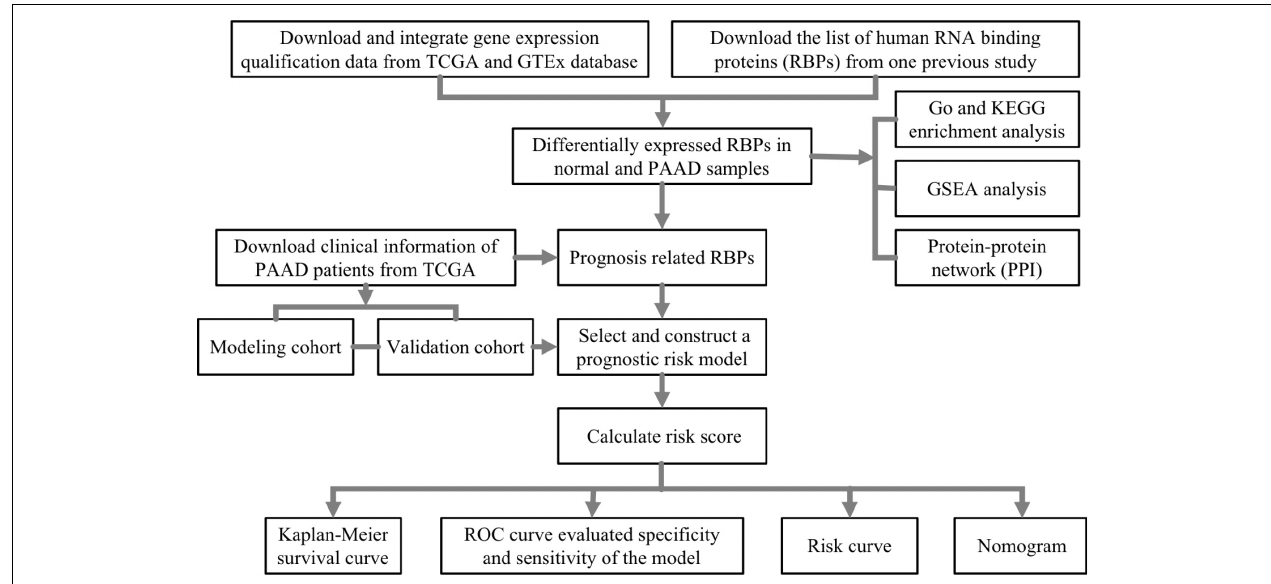
FIGURE 1 | The flowchart of analysis of RNA-binding proteins (RBPs) in pancreatic adenocarcinoma (PAAD).